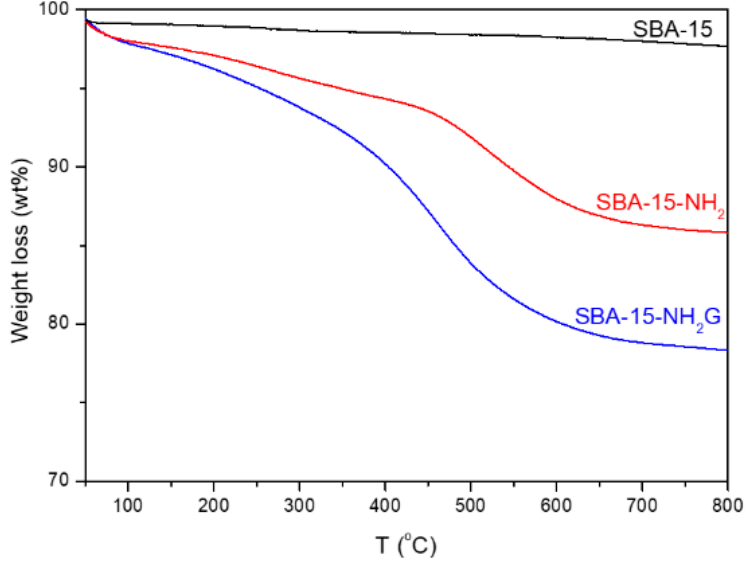
Figure 5. Thermogravimetric analysis of SBA-15 and functionalized materials.